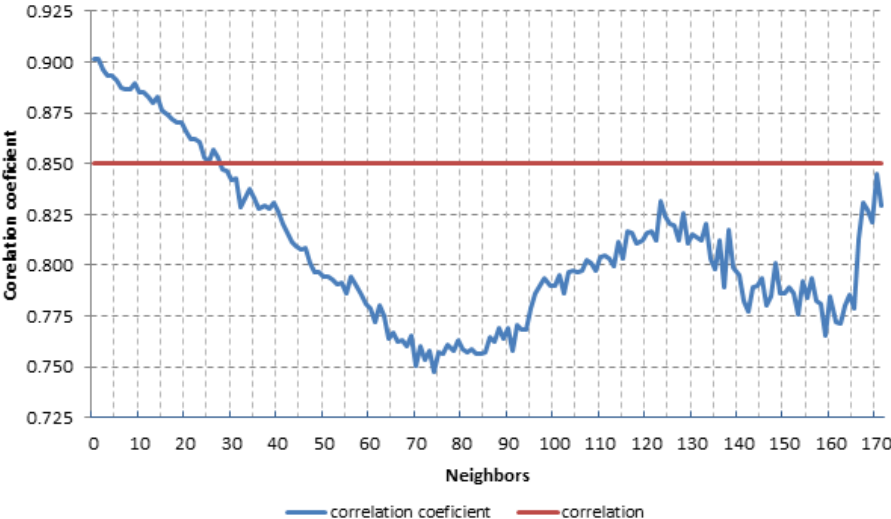
Figure 3. Daily price correlation for D nearest neighbor.